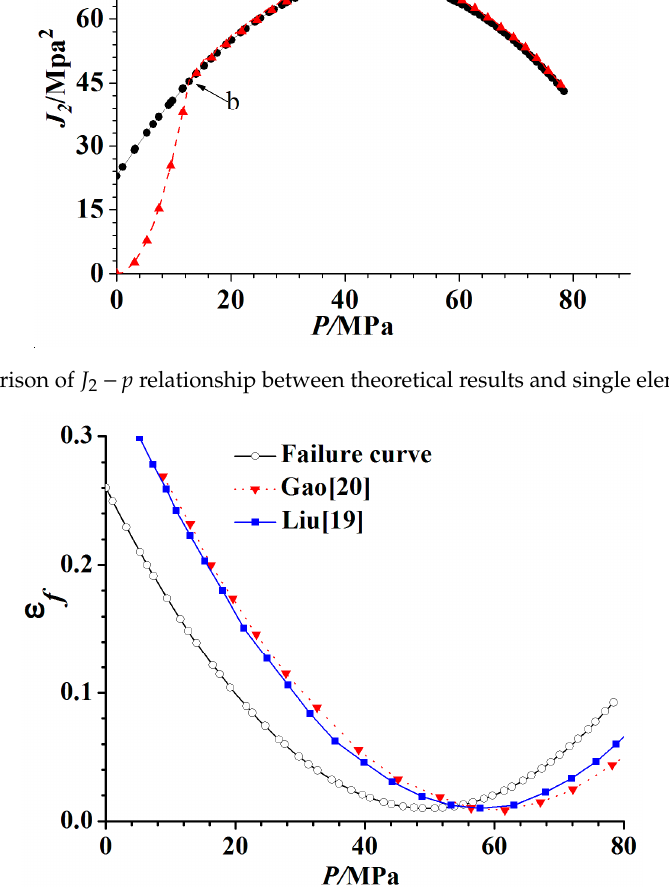
− p curves obtained from single element test and other researchers. J. Mar. Sci. Eng. 2020 , 8 , 193 8 of 22 p ε − curves obtained from single element test and other researchers. Figure 4. Comparison of ε f f p ε − curves obtained from single element test and other researchers. f